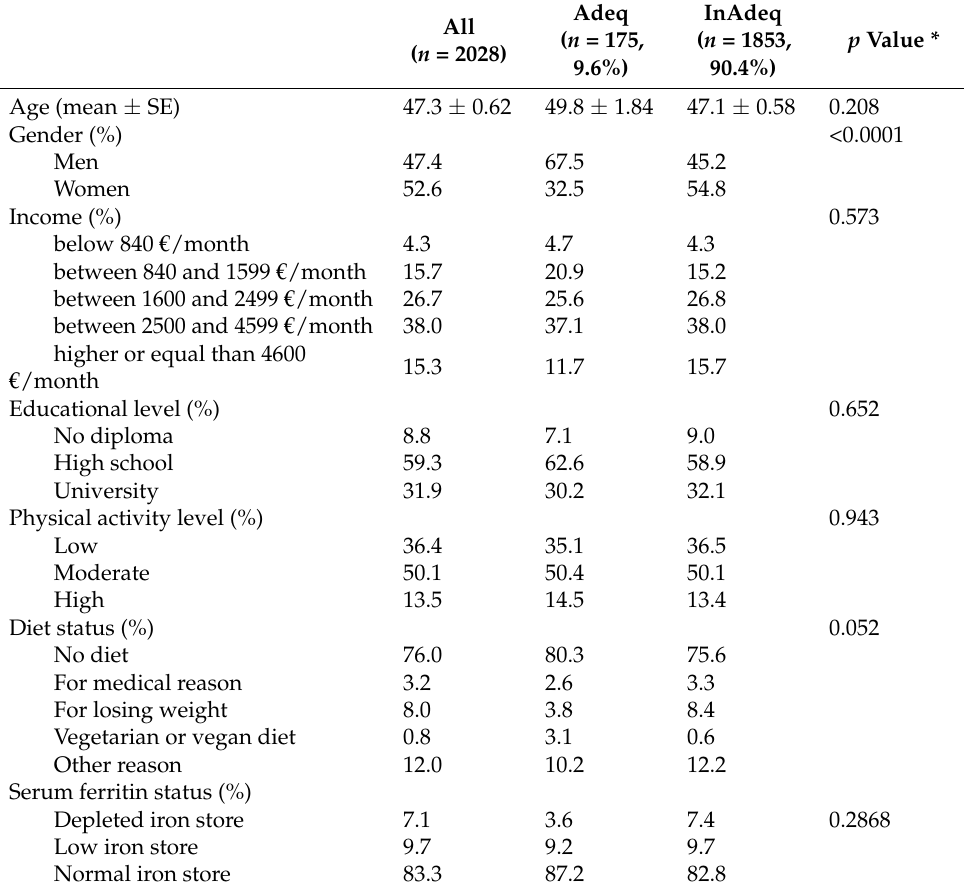
SE, Standard error of the mean. * Test of the difference of individual characteristics between Adeq and InAdeq individuals, using a linear generalized model for the age, and Chi-Squared test for qualitative